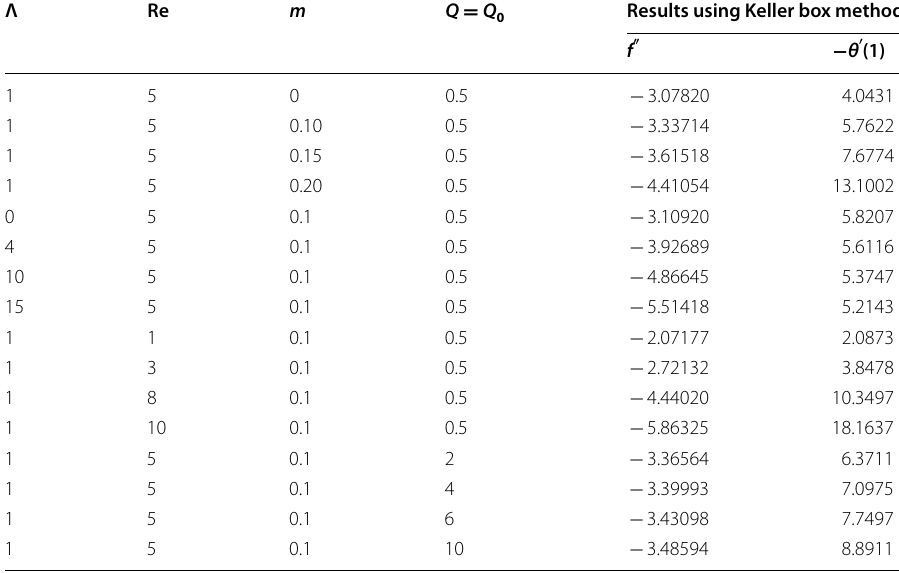
Table 3 Values of f ″ and M 1, S 0.6 and φ = =